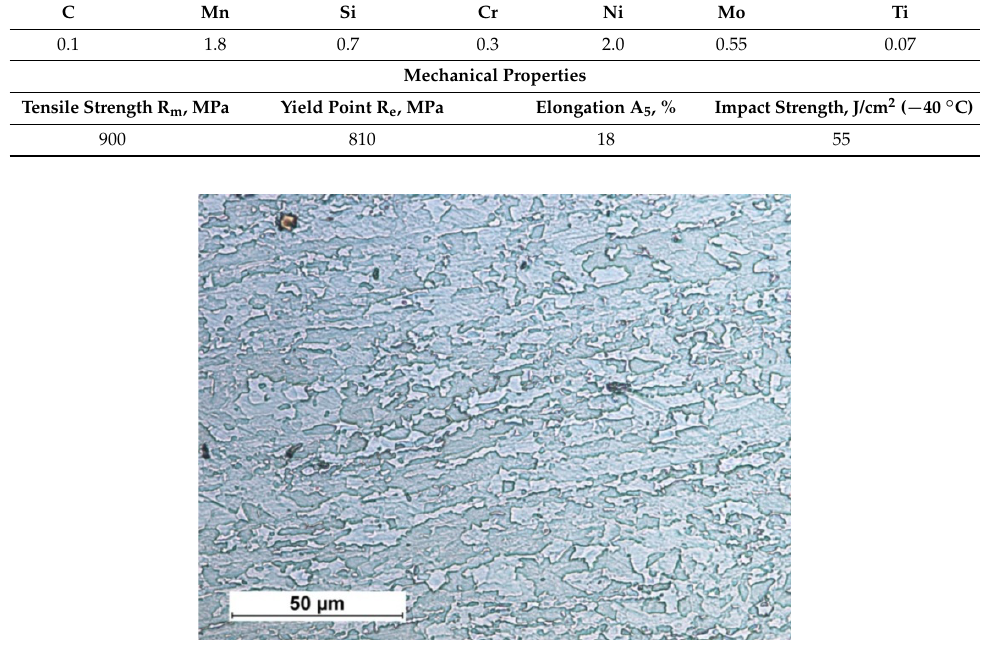
Table 2. Chemical composition and mechanical properties of filler metal GMn4Ni1.5CrMo.